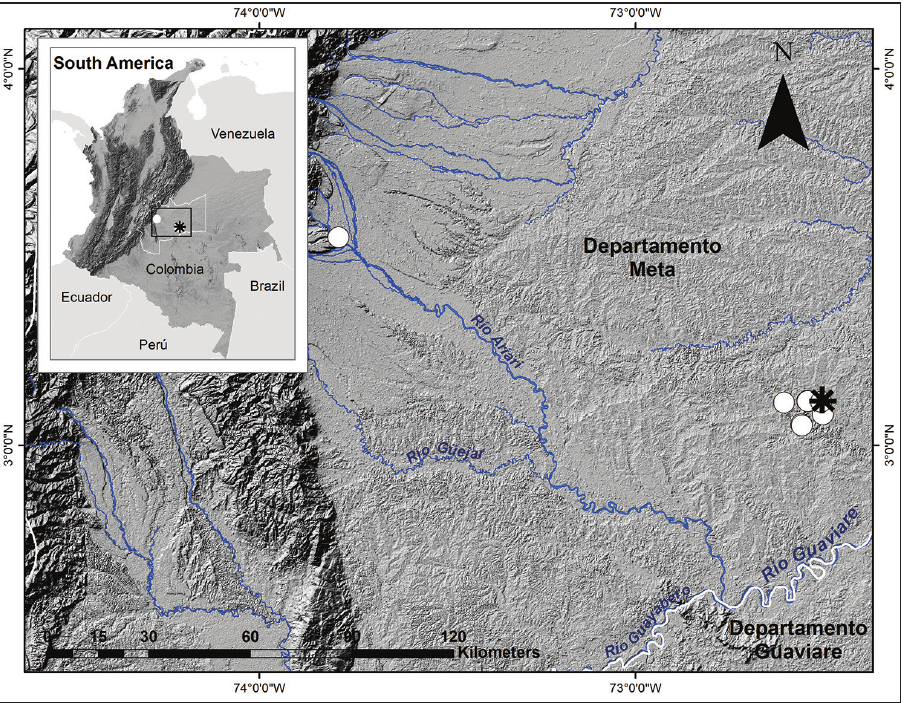
Figure 4. Distribution of Hyphessobrycon klausanni sp. n. in the upper tributaries of Guaviare River drainage. Type locality indicated by an asterisk.